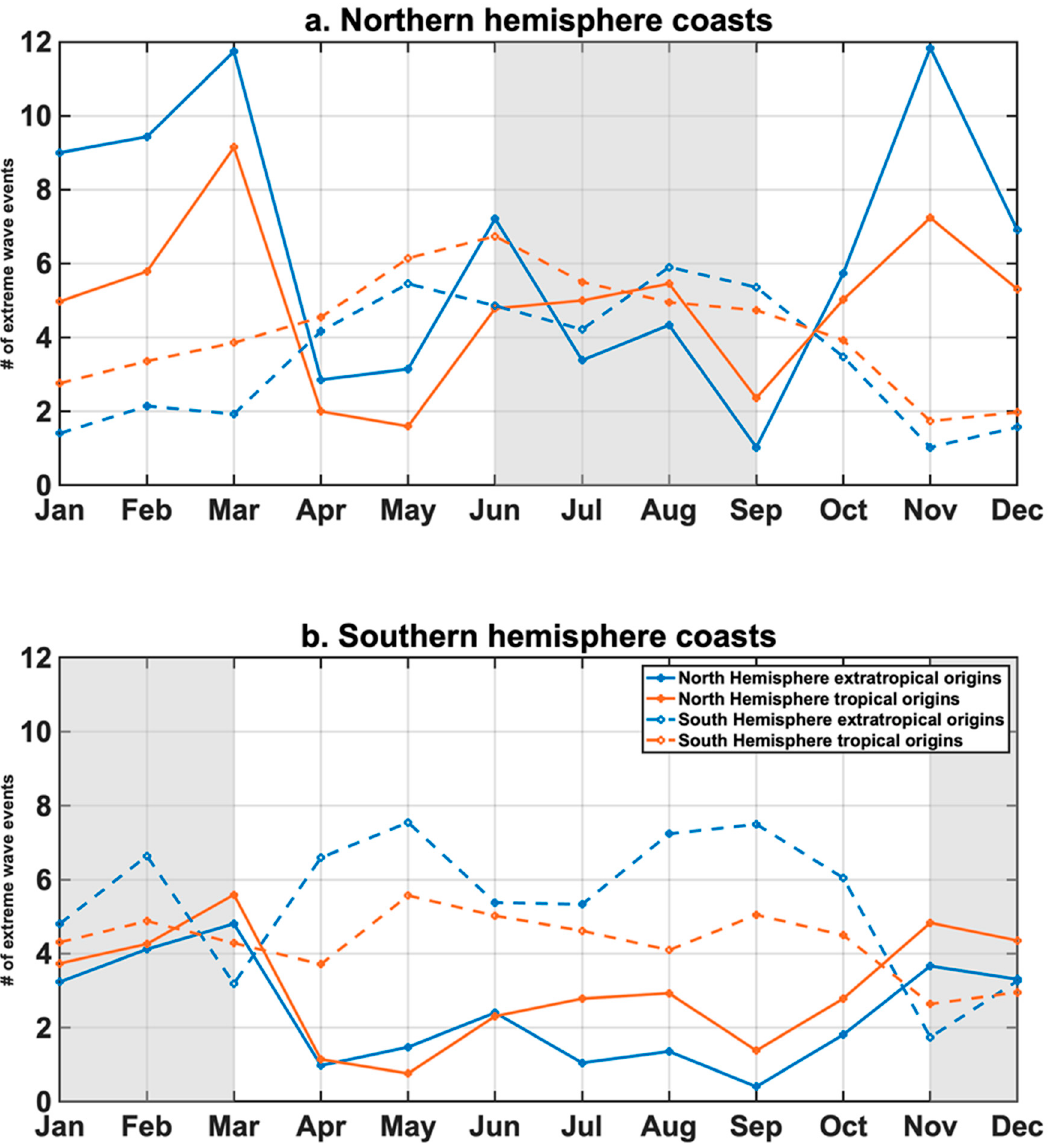
Figure 5. Monthly mean climatology of the number of extreme coastal events along the northern ( a ) and southern ( b ) hemisphere coastlines according to their oceanic origins: Northern (thick lines) vs. Southern (dashed lines) Hemisphere and tropical (orange lines) vs. extratropical (blue lines) origins. The boreal and austral tropical cyclone seasons are shaded in light grey on panels a and b, respectively.